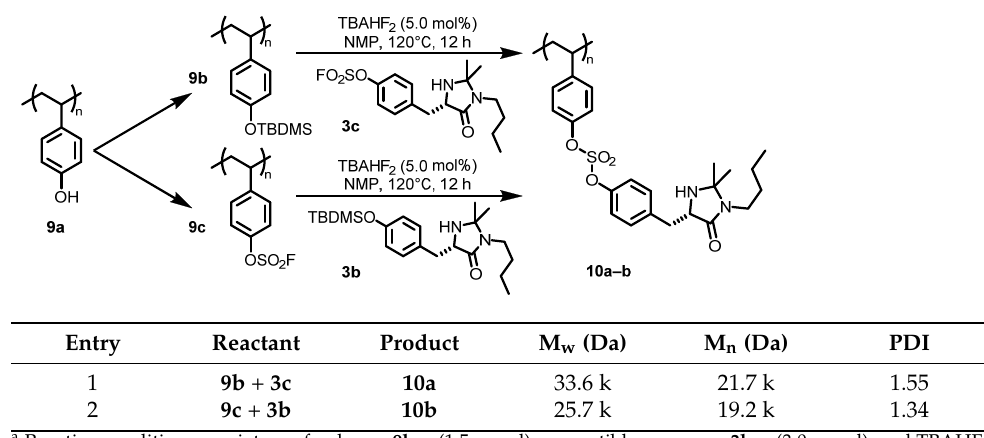
Table 3. Synthesis of Class III polymeric MacMillan catalysts a .